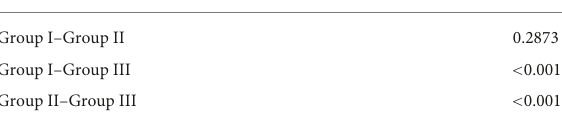
TABLE 4 Comparing thromboxane B2 at 4 h between